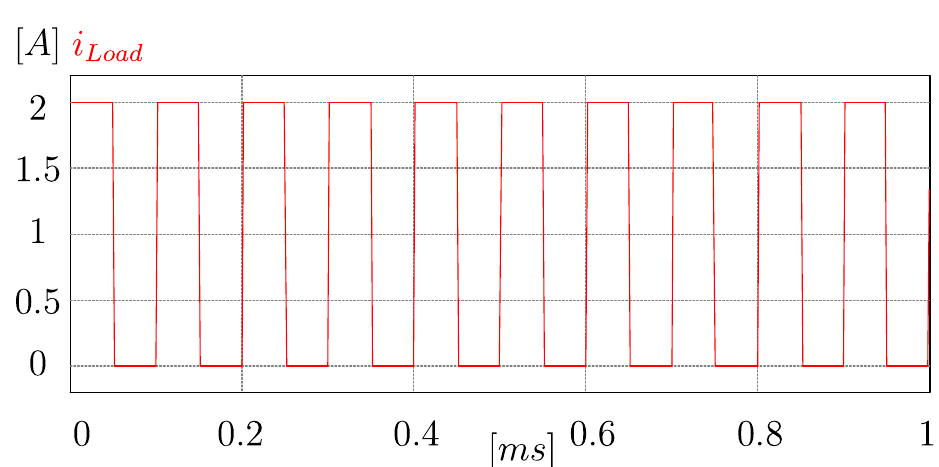
Figure 15. Zoom of the current pattern connected to the battery bank.